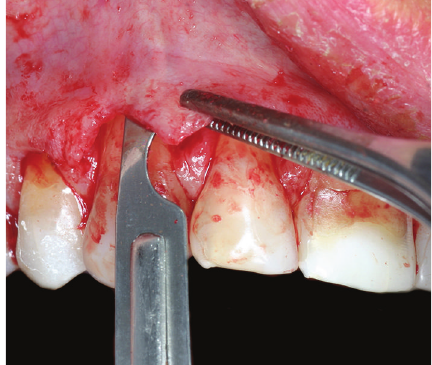
Figure 6: Superficial partial thickness elevation of the flap.